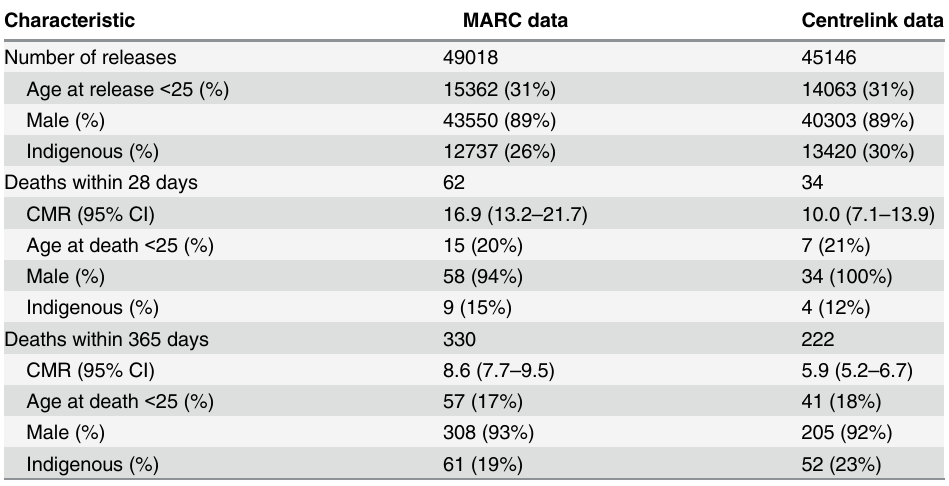
Table 3. Characteristics of releases and deaths among adults released from Queensland prisons 2000 – 2007, according to data source. Characteristic MARC data Centrelink